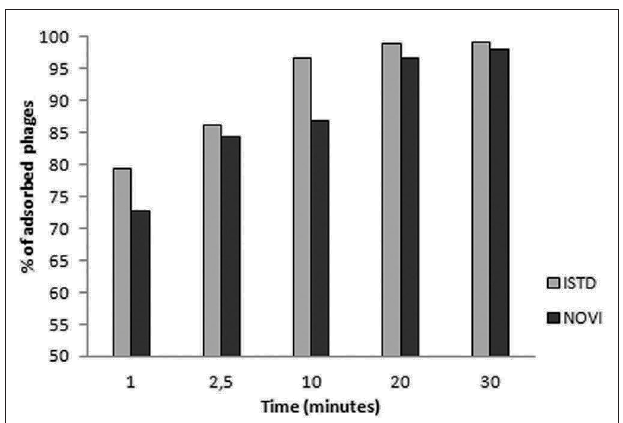
FIGURE 3 | Adsorption rates of phages ISTD and NOVI on A. baumannii 6077/12. Bars indicate the percentage of adsorbed phages at different time points. Each bar represents the mean of three independent measurements.